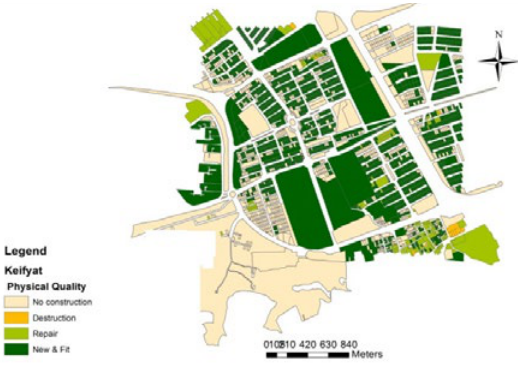
Fig. 4: Population Density in study area